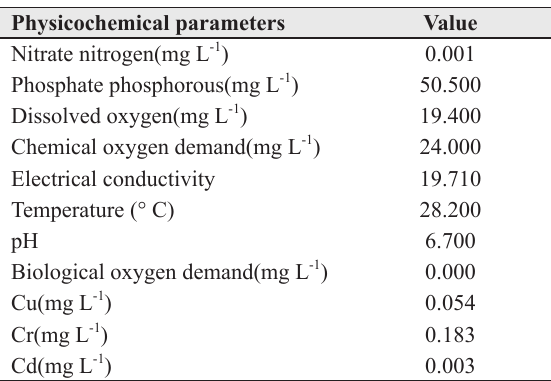
The physicochemical characteristics of the Indigo dye effluents used in the present